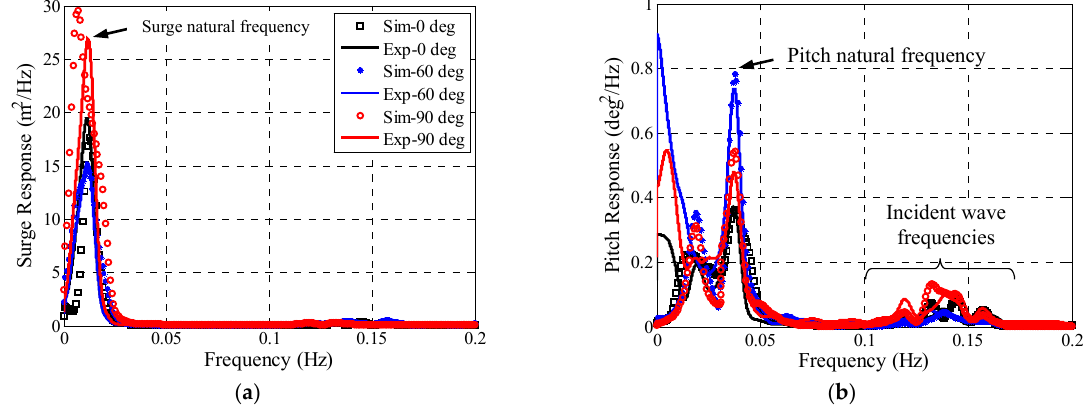
Figure 22. Comparisons of ( a ) surge and ( b ) pitch PSD between three aligned wind/wave directions.